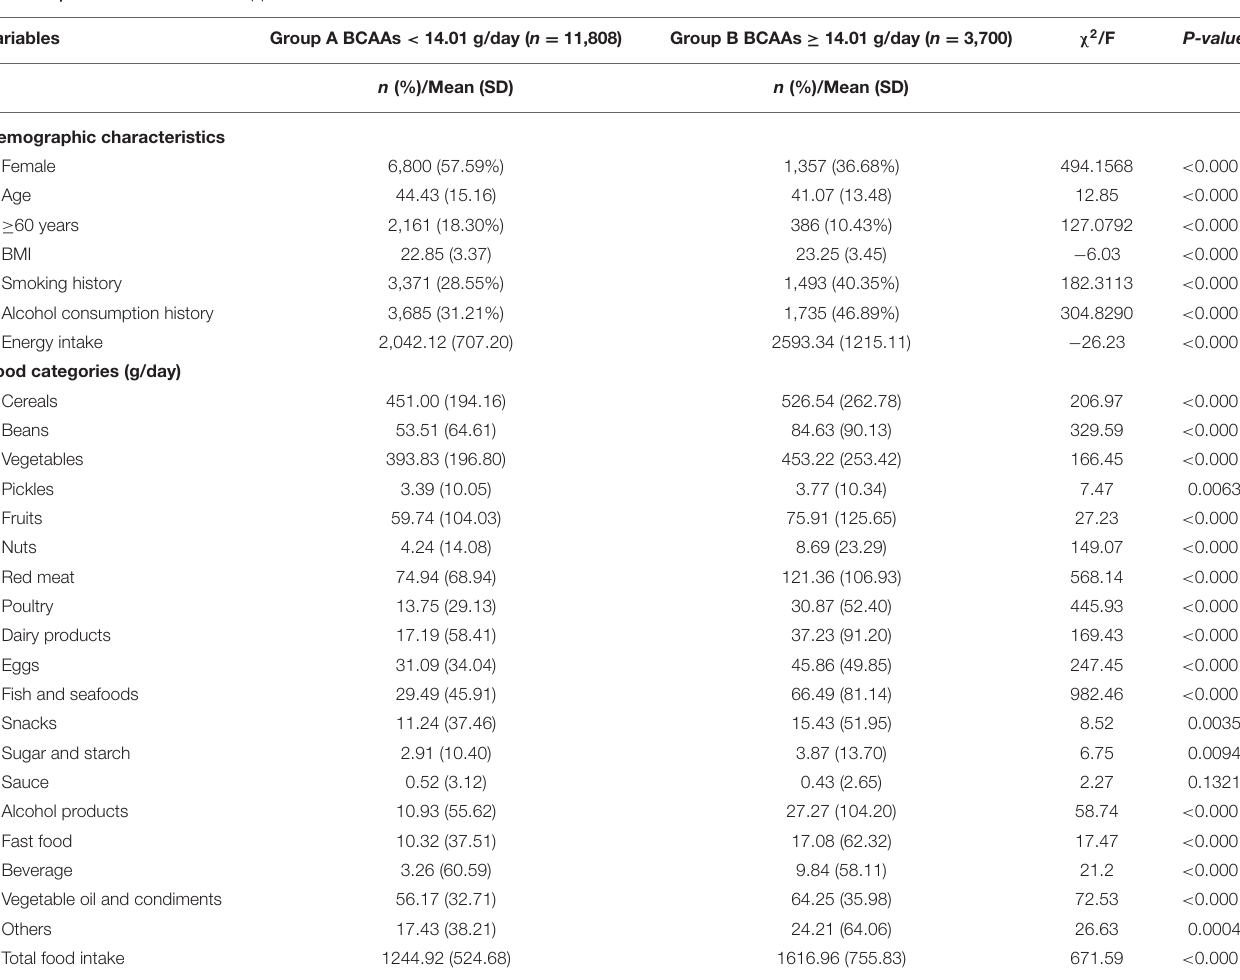
TABLE 4 | Differences in diet with upper and lower thresholds of